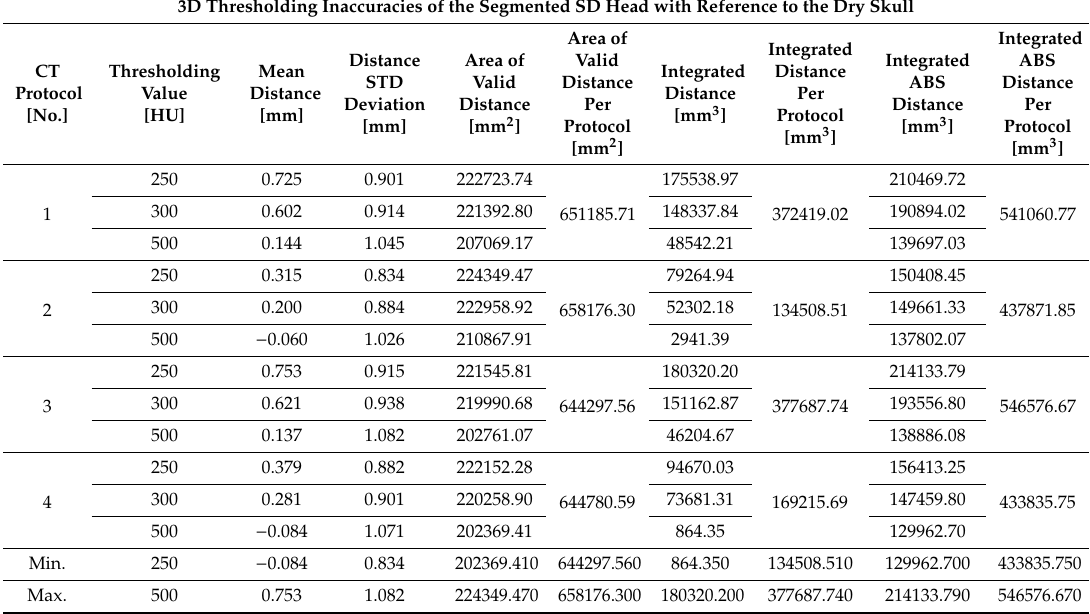
Table 6. Three-dimensional (3D) thresholding inaccuracies of the SD head intact with its soft tissue. 3D Thresholding Inaccuracies of the Segmented SD Head with Reference to the Dry Skull